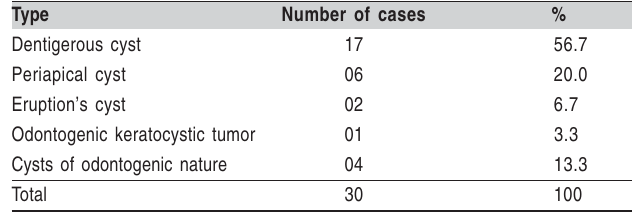
Table 2 - Distribution of cases of odontogenic cysts, in order of frequency. São Luís, MA-2010.